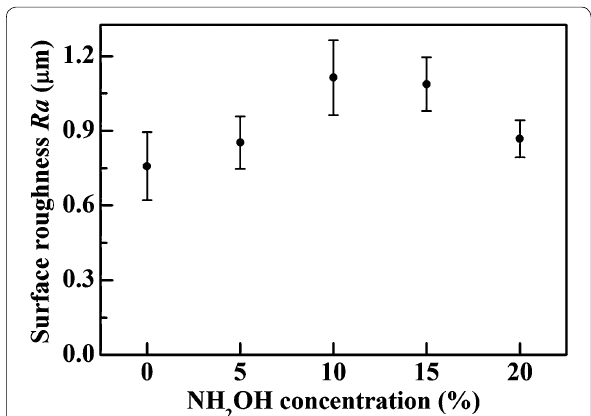
Fig. 4 Average surface roughness ( Ra ) in 20 wt% KOH solution with- out and with addition of NH 2 OH solutions at 75